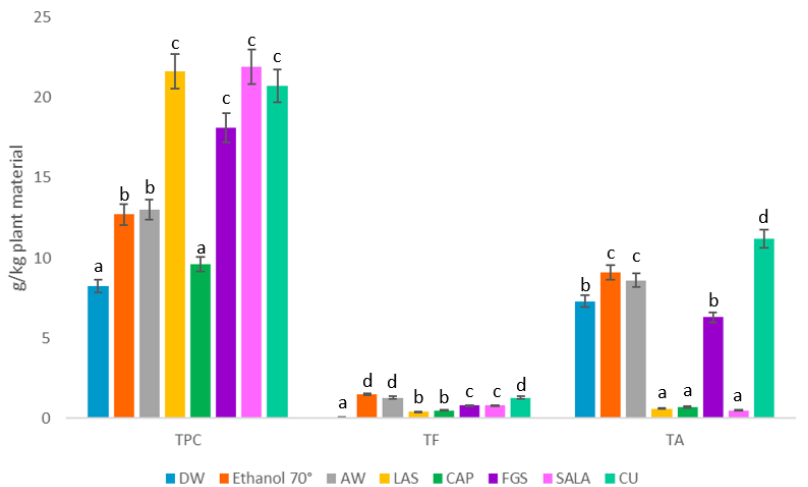
Figure 6. Extraction yield of total phenolic compounds (TPC); total flavonoids (TF) and total alkaloids (TA) in g/kg plant material. DW: distilled water; AW: Acetone: water; NaDES: sucrose: lactic acid: distilled water (LAS), citric acid: propylene glycol (CAP), fructose: glucose: sucrose: distilled water (FGS), sucrose: lactic acid: distilled water (SALA), choline choride: urea: distilled water (CU). Different letters in each column indicate significant differences in the TPC, TF and TA content between extracts according to Tukey’s test ( p ≤ 0.05).